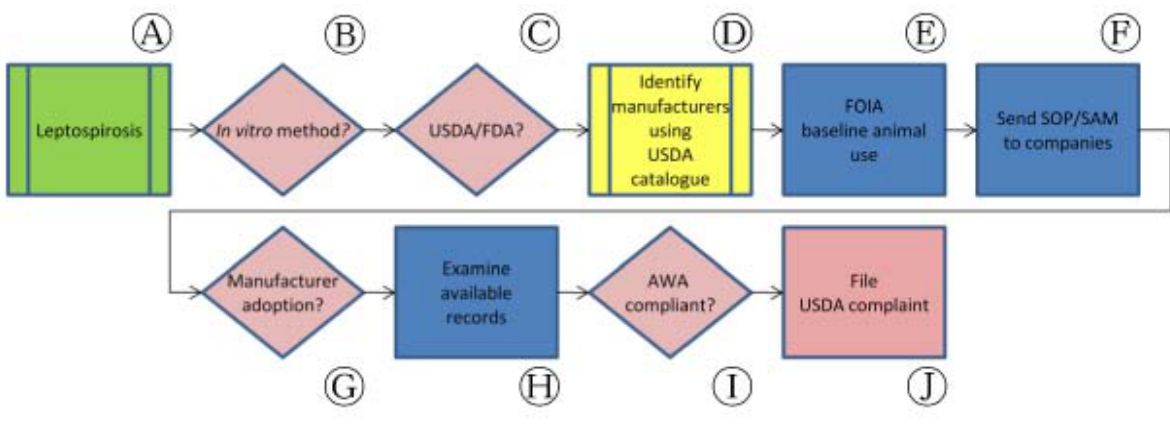
Figure 3. Application of bridging paradigm to leptospirosis vaccine potency testing in the United